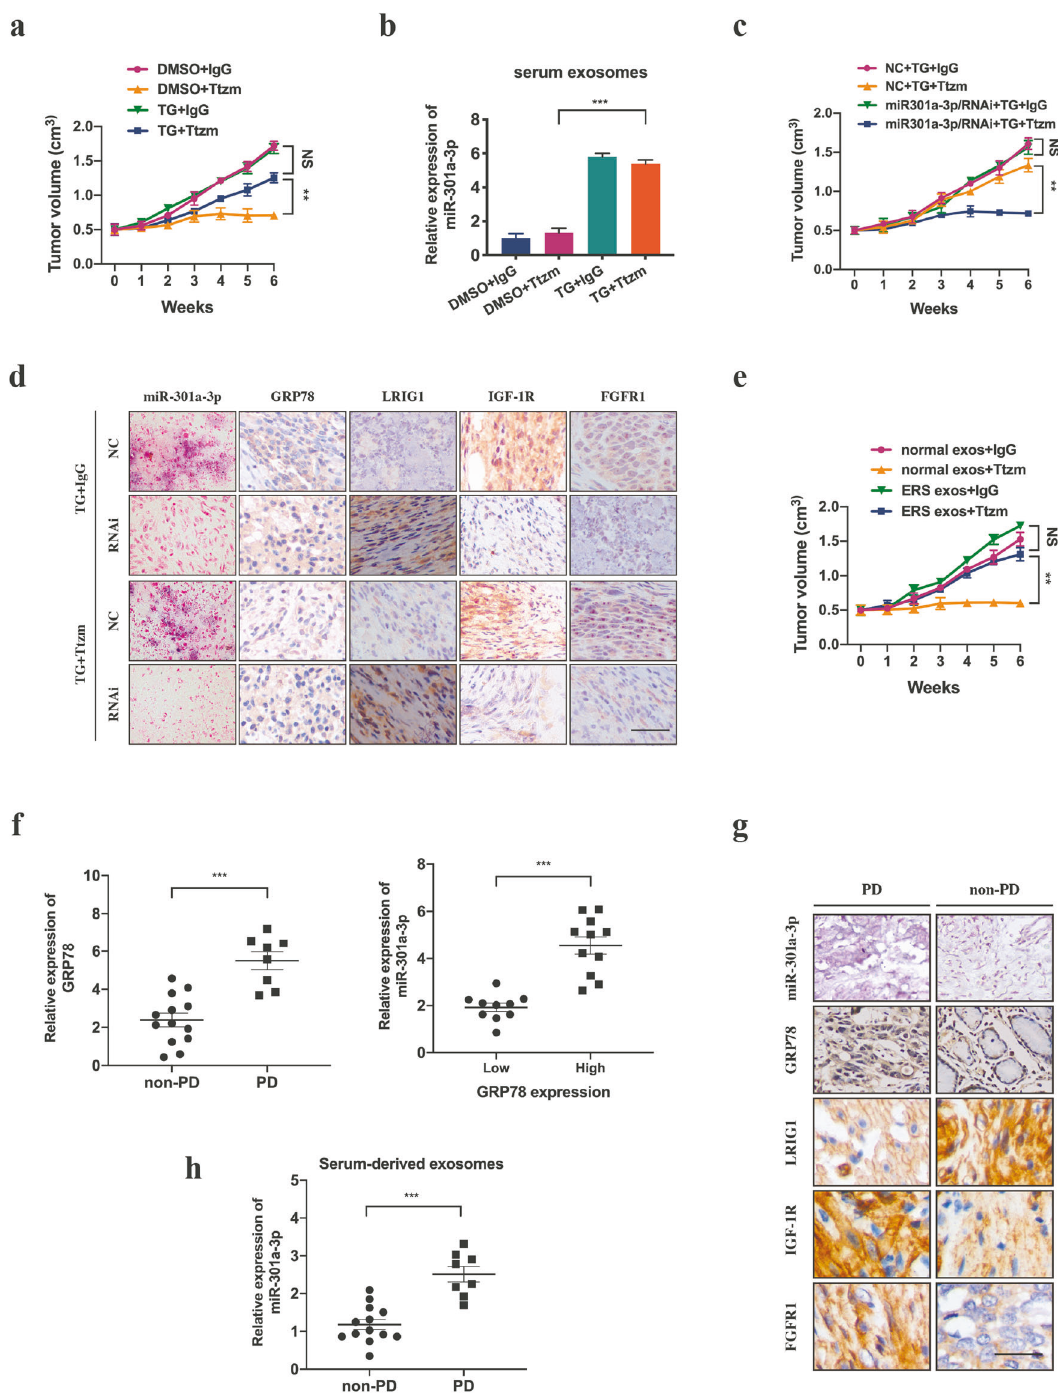
Fig. 7 miR-301a-3p induced by ER stress mediates trastuzumab resistance in vivo and in HER2-positive GC patients. a Subcutaneous xenograft assay of NCI-N87 cells in mice with subcutaneous injection of TG or DMSO upon trastuzumab or control IgG treatment for indicated days. The volumes of the tumours were shown ( n = 5 in each group). b qRT-PCR analysis of serum exosomal miR-301a-3p level from mice by different treatments n = 3. c Subcutaneous xenograft assay of NCI-N87 cells in the mice with subcutaneous injection of certain exosomes and trastuzumab or control IgG treatment for indicated days. The volumes of the tumours were shown ( n = 5 in each group). d Representative ISH images of miR-301a-3p and IHC images of indicated proteins in tumour sections of different groups ( n = 5 in each group). Scale bar: 50 μ m. e Subcutaneous xenograft assay of NCI-N87 cells in the mice with subcutaneous injection of certain exosomes and trastuzumab or control IgG treatment for indicated days. The volumes of the tumours were shown ( n = 5 in each group). f GRP78 mRNA level of HER2-positive GC patients suffering from PD or non-PD after trastuzumab therapy and miR-301a-3p expression level of HER2-positive GC patients with high or low GRP78 expression. g Representative ISH images of miR-301a-3p and IHC images of indicated proteins in tumour sections from HER2-positive GC patients suffering from PD or non-PD after trastuzumab therapy. Scale bar: 50 μ m. h miR-301a-3p expression level of serum-derived exsomes in HER2-positive GC patients suffering from PD or non-PD after trastuzumab therapy. Statistical analysis was performed by Student ’ s t -test and one-way ANOVA, error bars indicate SD (** p < 0.01, *** p < 0.001). Cell Death and Disease (2021)